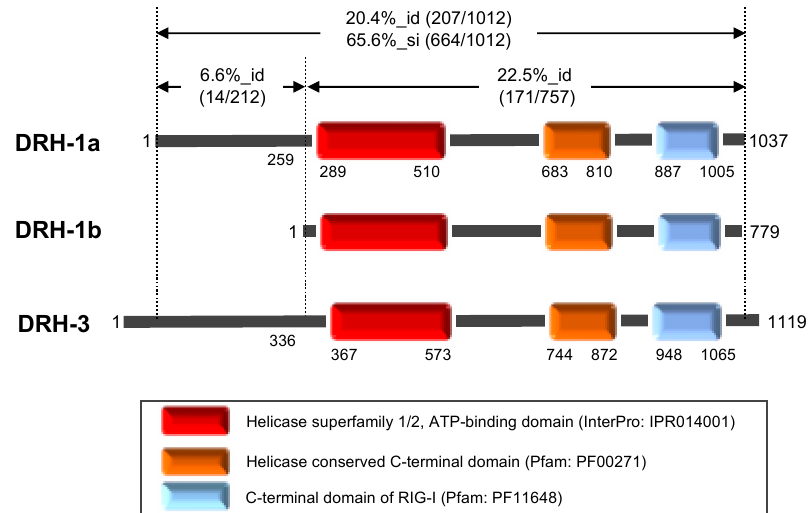
Figure 1. The Caenorhabditis elegans Dicer-related helicase (DRH) proteins prepared in this study. The schematic structures of DRH-1 isoforms a and b and of DRH-3 are shown. Numbers indicate the amino acid residue positions. DRH-1 isoform b lacks the N-terminal 258-amino acid region that is present in isoform a. The three domains conserved in DRHs and the positions of their amino acid residues are indicated by the box outlines. The percent identity (%_id) and / or similarity (%_si) in the entire region as well as the N-terminal and the central-to-C-terminal regions between DRH-1a and DRH-3 are indicated as the number of identical or similar residues in the total number of residues in the region.